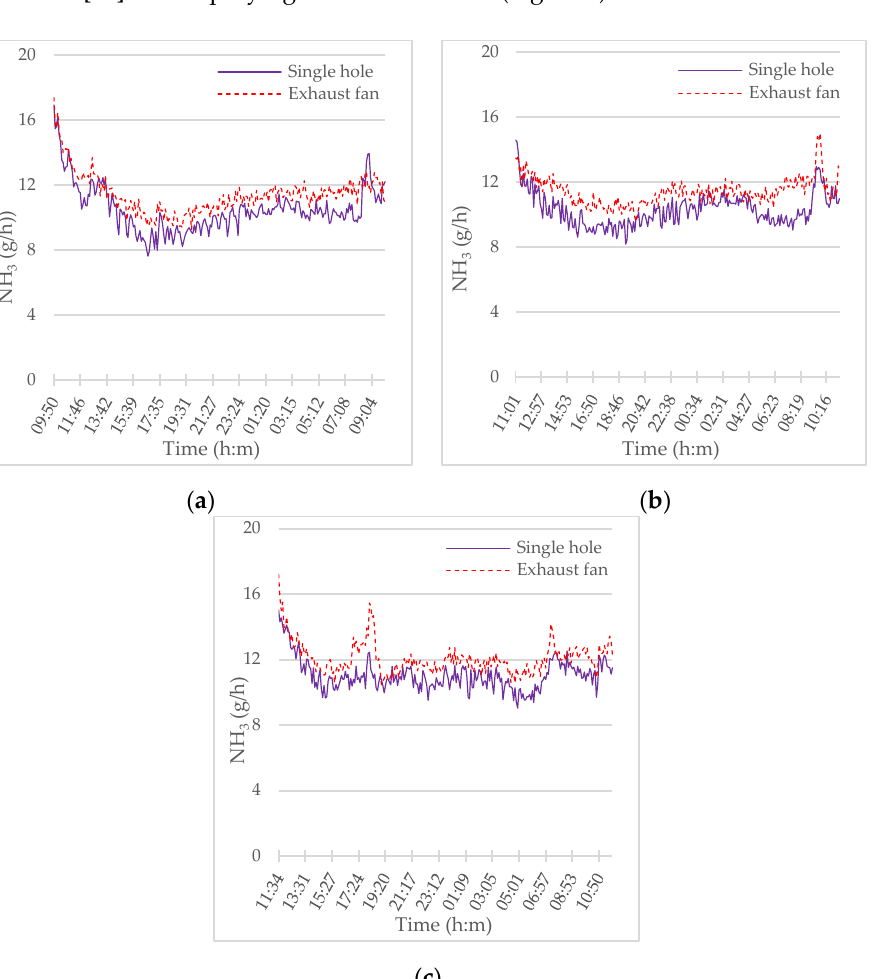
Figure 4. The ammonia (NH 3 ) reduction effect in non-spray conditions inside the curtain: ( a ) the maximum operating rate of the barn exhaust fan (100%), ( b ) minimum operating rate of barn exhaust fan (30%).